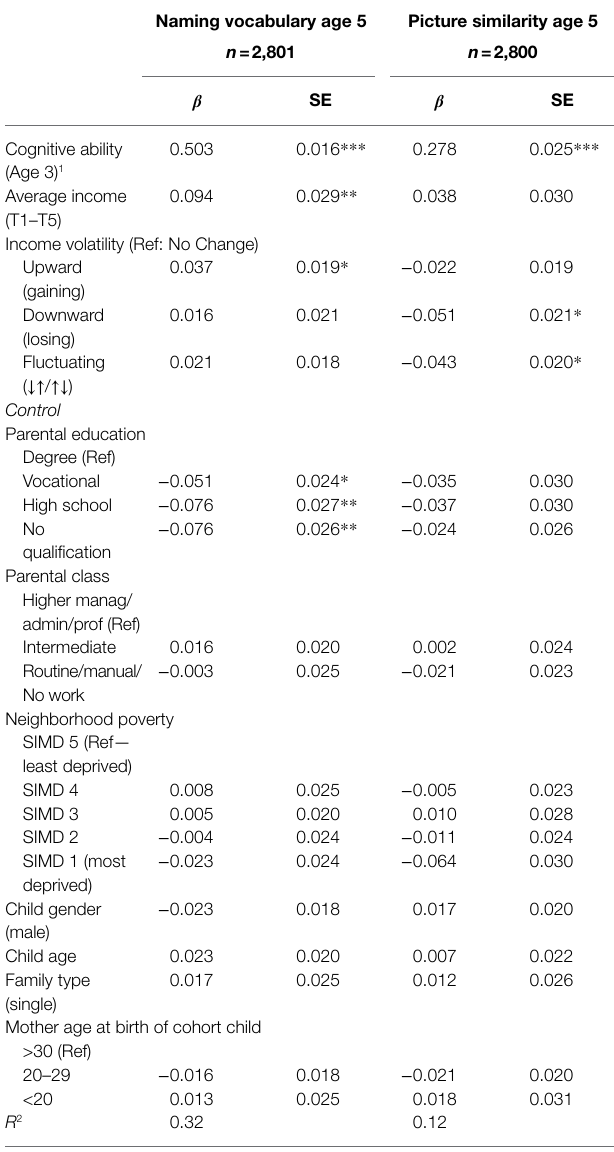
TABLE 5 | Standardized regression coefficients of income dynamics (average income and volatility) and change in cognitive ability from ages 3 to 5. Naming vocabulary age